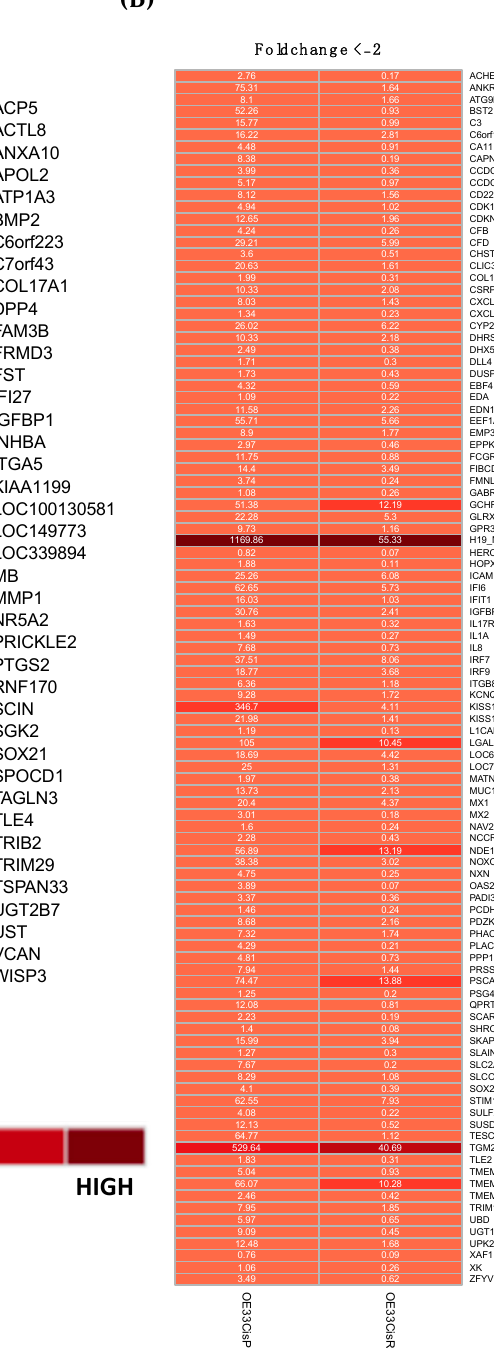
Figure 3. OE33 Cis R cells have a significantly altered gene expression profile compared to OE33 Cis P cells. Heatmaps were generated from gene expression data after applying a fold change filter ± two. ( A ) Heatmap showing 42 genes that were significantly upregulated in OE33 Cis R cells with a fold change of greater than two. ( B ) Heatmap showing 104 genes which were significantly downregulated in OE33 Cis R cells with a fold change of less than minus two. Gene expression values shown as Fragments Per Kilobase of transcript per Million mapped reads